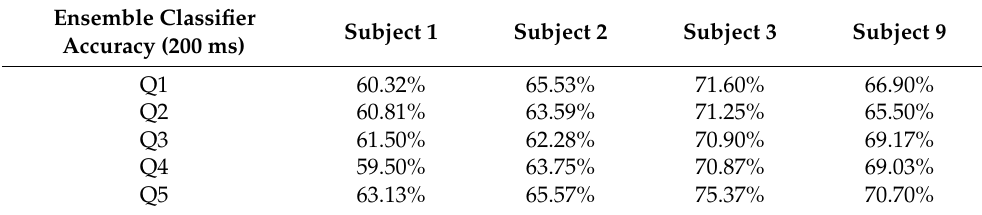
Table 3. Accuracy of different combinations across different subjects